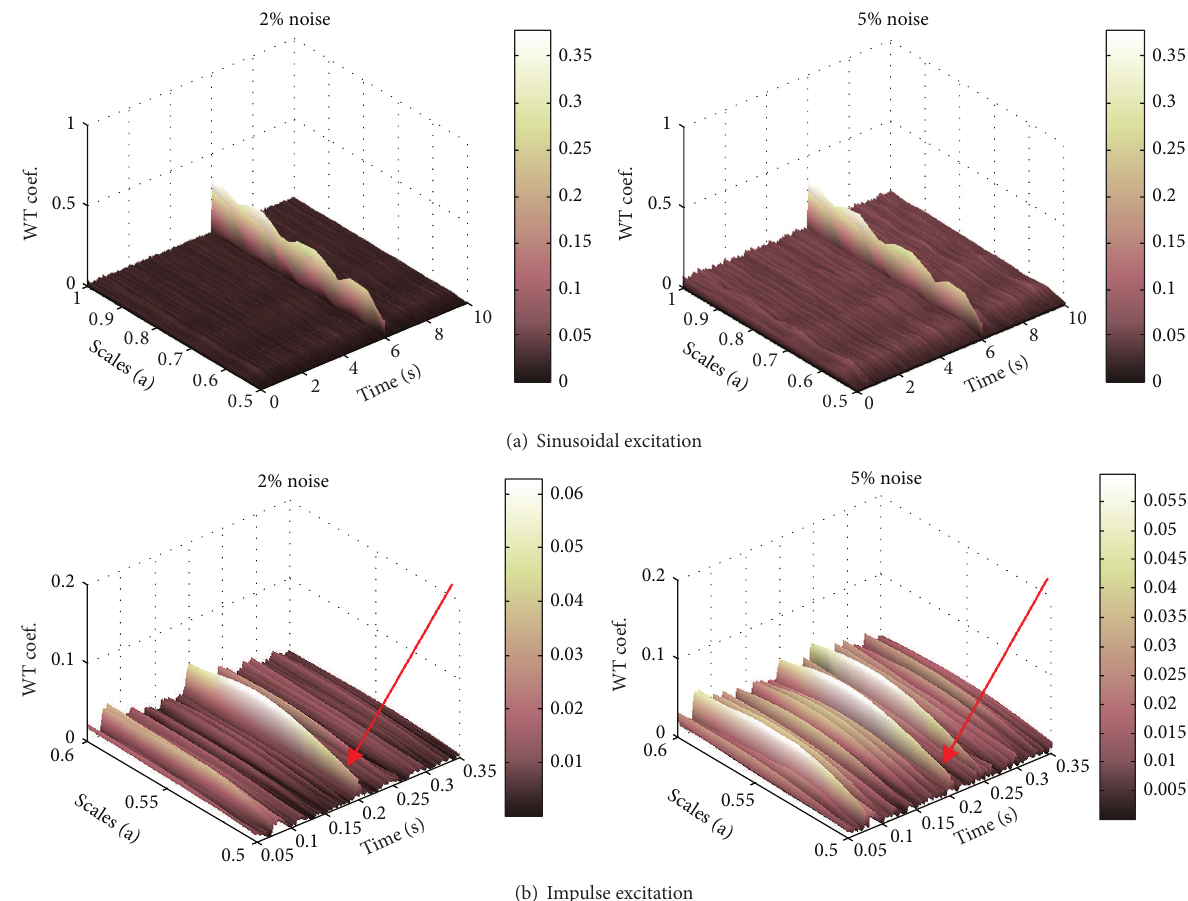
Figure 15: Detection results from contaminated acceleration responses (noise frequency range 0 ∼ 250 Hz).